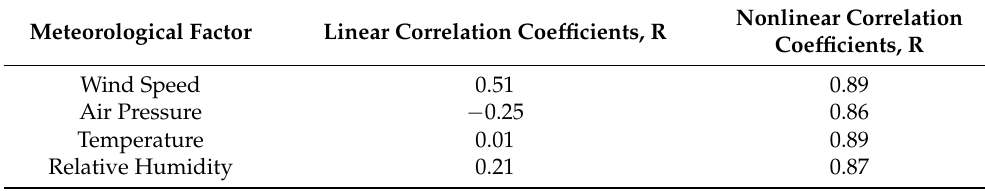
Table 3. Correlations between AOD and meteorological factors in the dry season. Meteorological